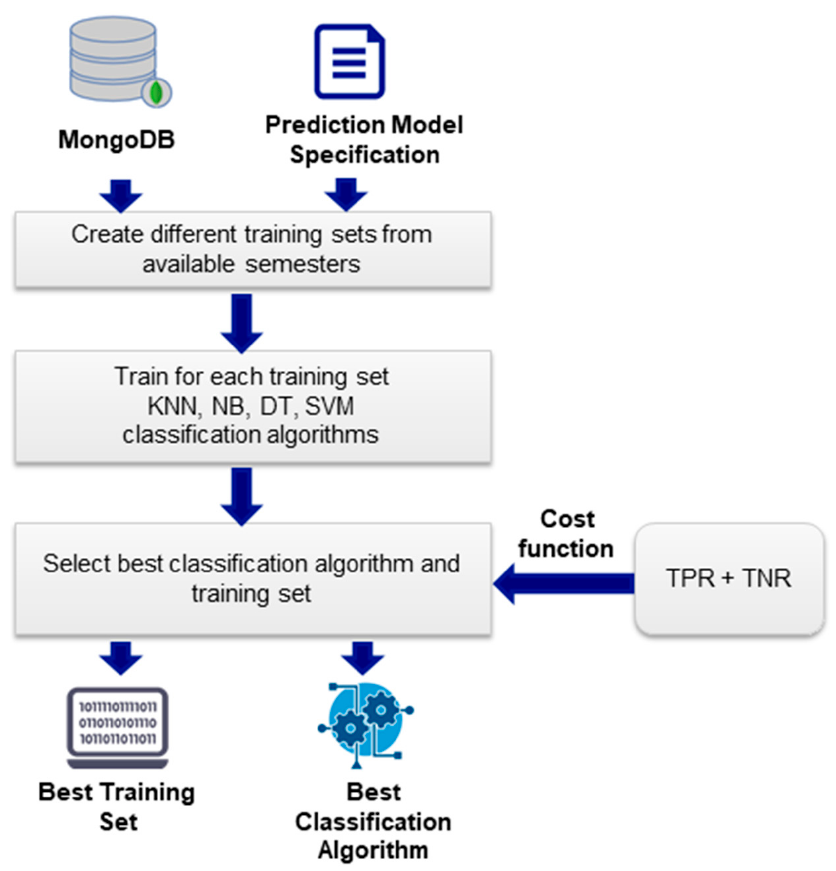
Figure 6. Procedure to obtain each submodel of the PGAR model.